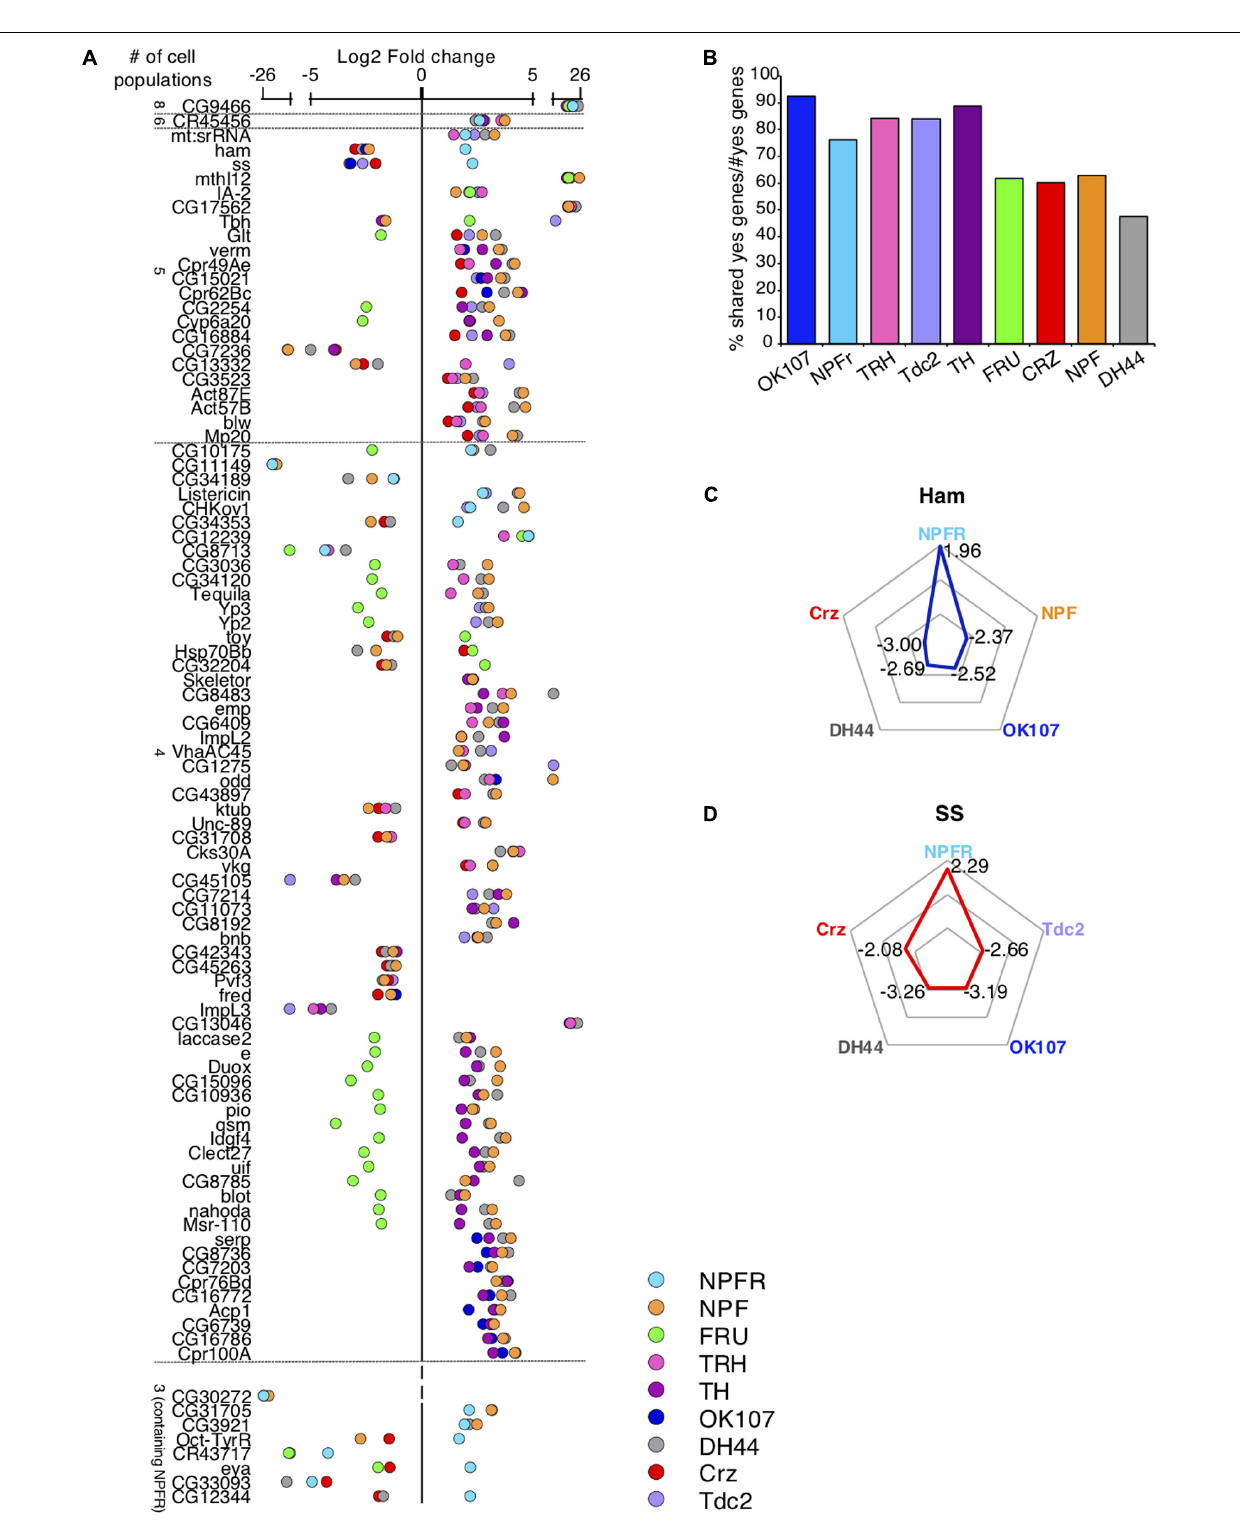
Frontiers in Behavioral Neuroscience |